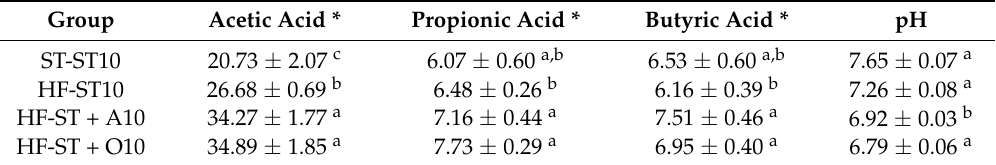
Table 2. The effect of the diet shift and agavins supplementation on short-chain fatty acid concentration and pH in the cecal content of overweight mice. Group Acetic Acid